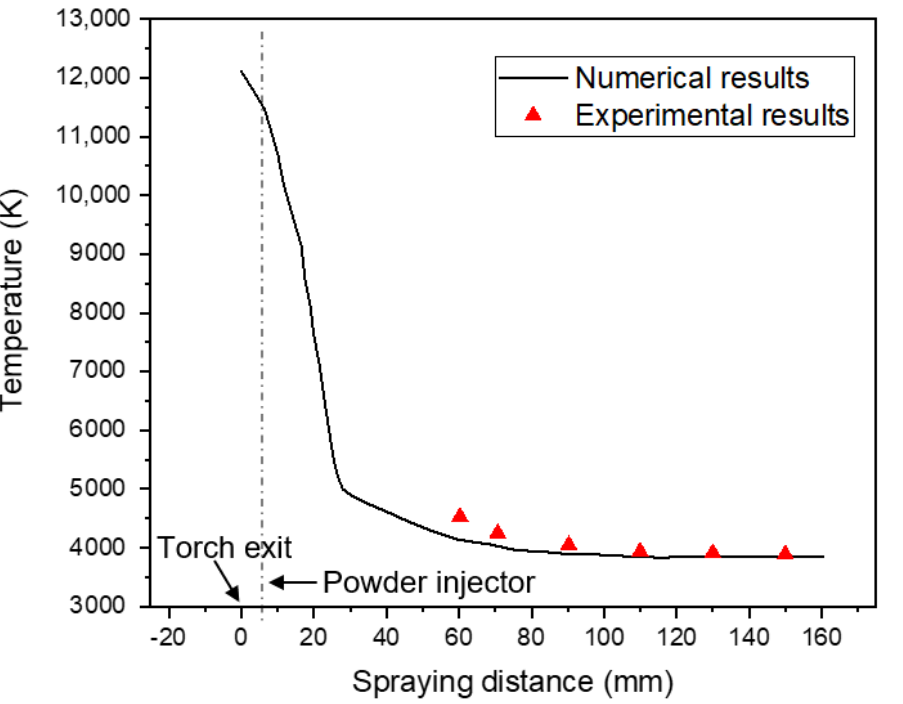
Figure 6. Calculated and experimental measurement of plasma jet temperature profiles at the centerline axis as a function of spraying distance. Numerical results of a turbulent plasma argon jet emerging in an argon atmosphere with particle injection are presented here. As a precursor material, silicon particles of 20 µm average diameter are freed simultaneously with argon gas in the plasma flame. Carrier gas and plasma mass flow ratio are assumed as 0.06 and 0.2 for an injection gas speed of 10 or 30 m/s, respectively. At first, the variation of calculated plasma jet